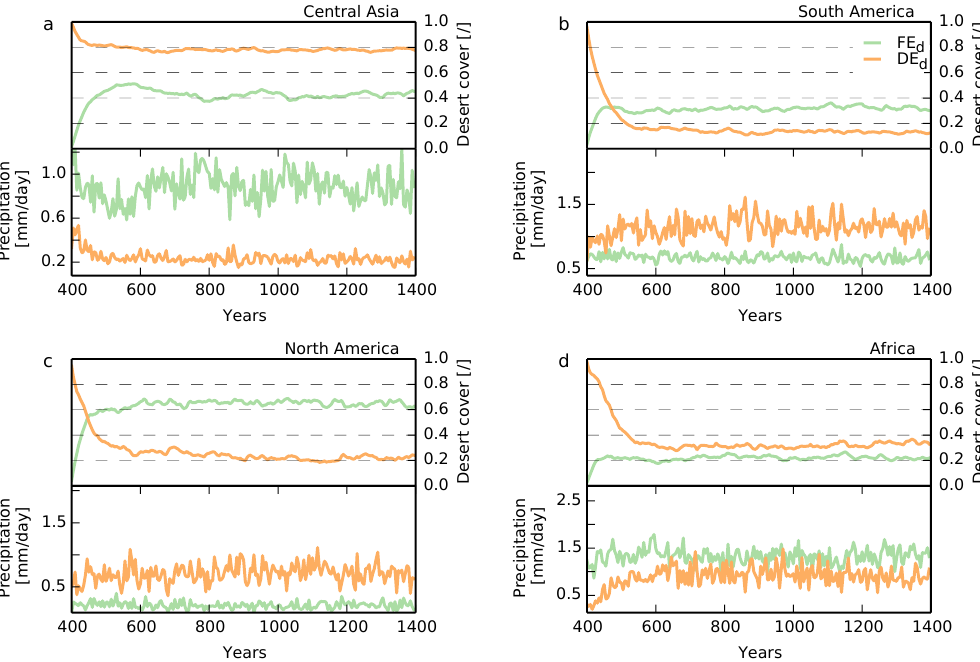
Figure 4. Time series of 5-year mean desert cover and precipitation in selected regions in central Asia (a) , South America (b) , North America (c) , and Africa (d) in the FE d simulation (green line) and in the DE d simulation (orange line). The regions are marked in Fig. 3.